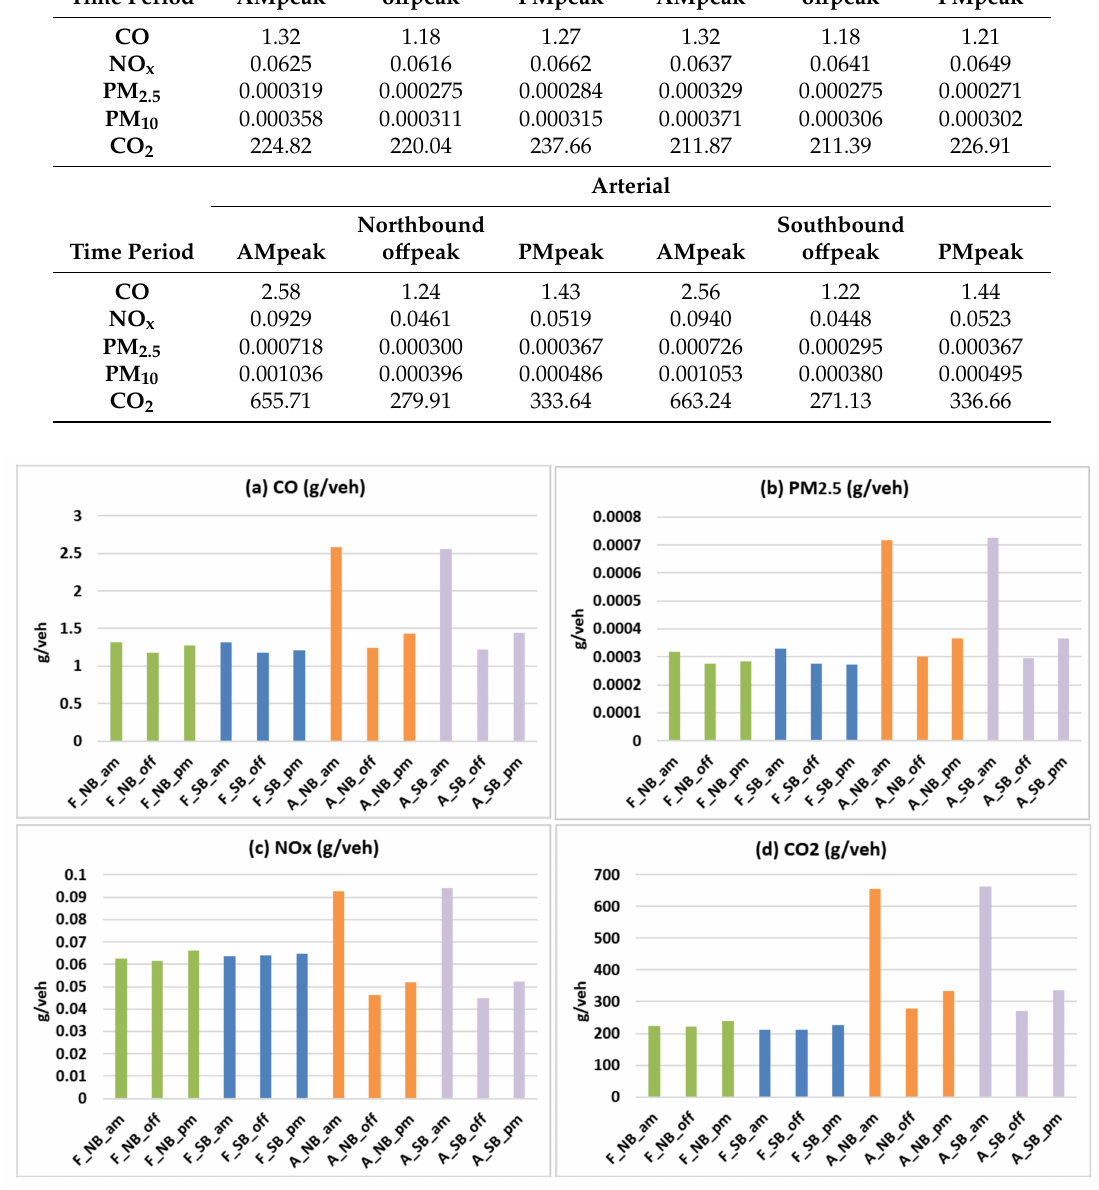
Figure 3. Estimated Link Emission Factors by Pollutant